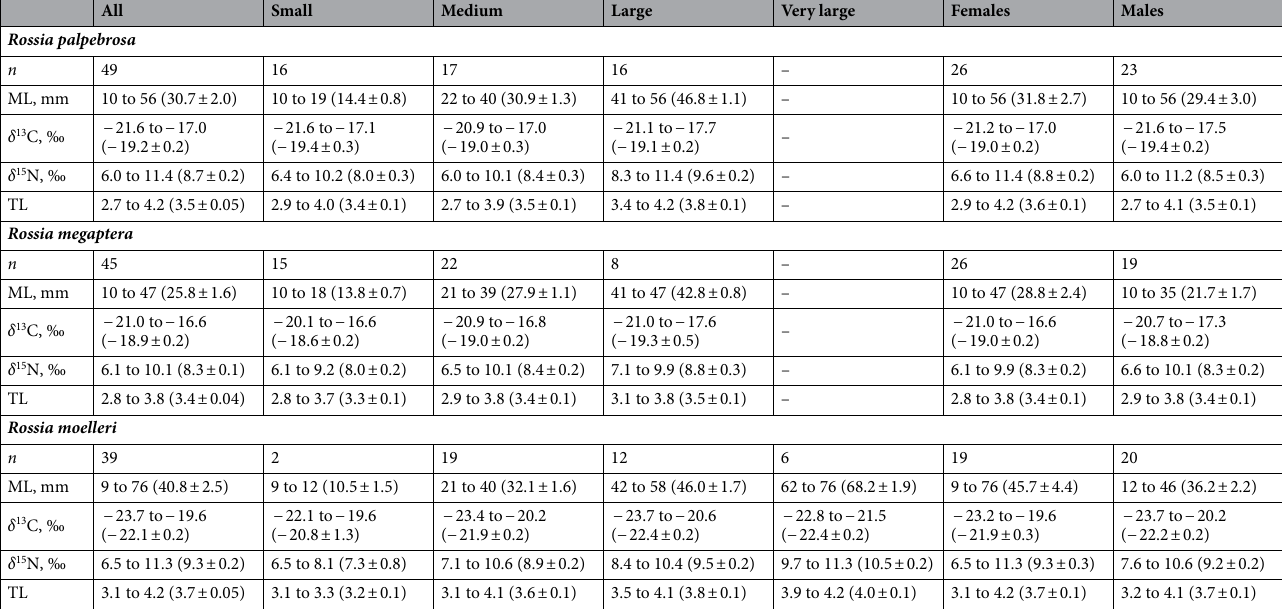
Table 2. Mantle length (ML), values of δ 13 C and δ 15 N and estimated trophic level (TL) in the studied species of the genus Rossia by stage and sex, and for pooled data. Values are minimum − maximum (mean ± SE), n sample size.